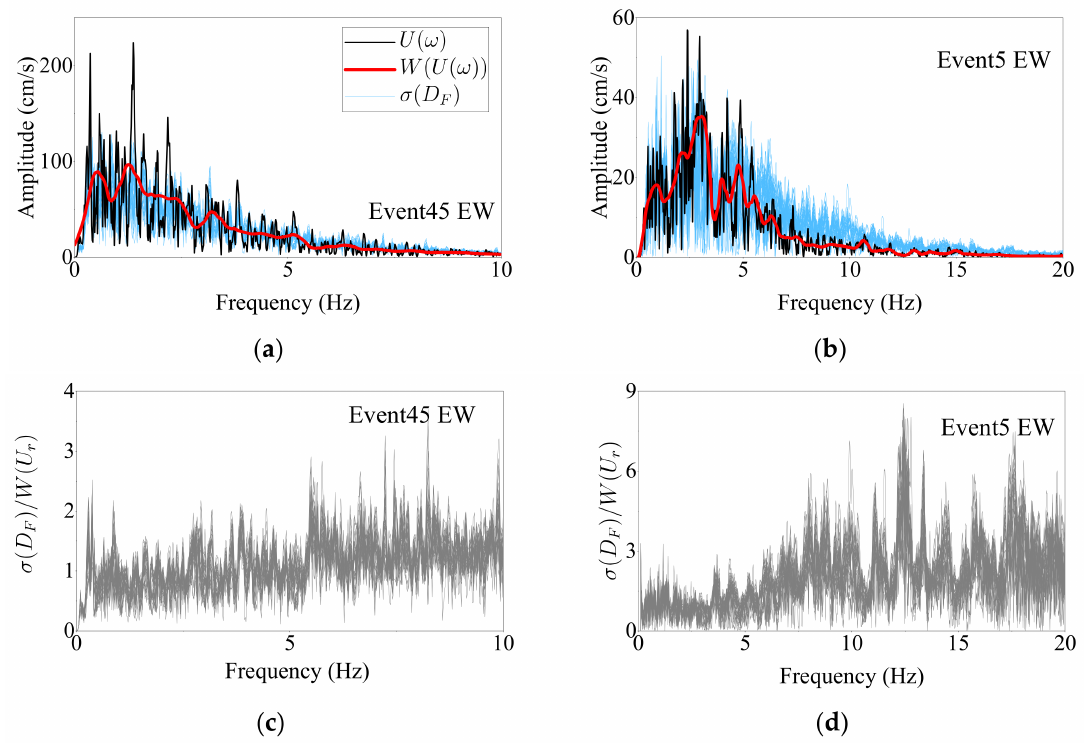
Figure 10. Its envelop in Event 45 and 5: ( a , b ) σ ( D F ) , ( c , d ) normalized σ ( D F ) . By removing the wavelet approximation from the deviation, the results, σ ( D F ) / W ( U r ) , of Event 45EW and Event 5EW are presented in gray lines in Figure 10c,d. In Figure 10c, σ ( D F ) / W ( U r ) stays constant from 0.2 Hz to around 5 Hz and increases at around 5 Hz